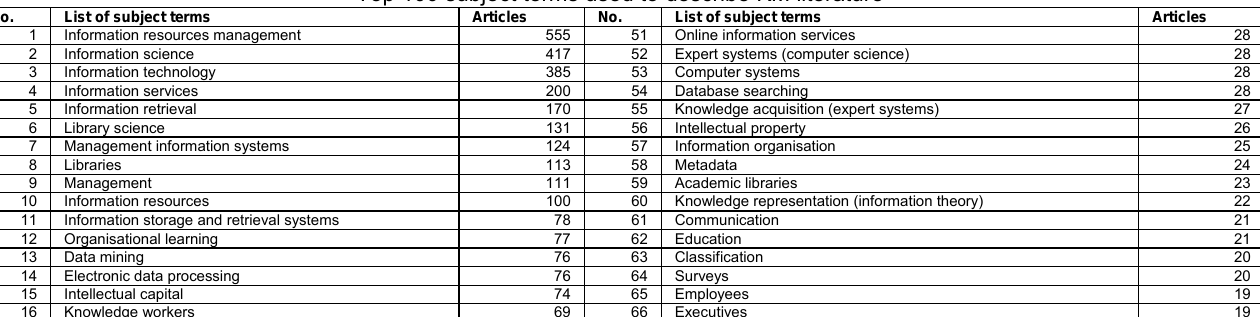
Top 100 subject terms used to describe KM literature